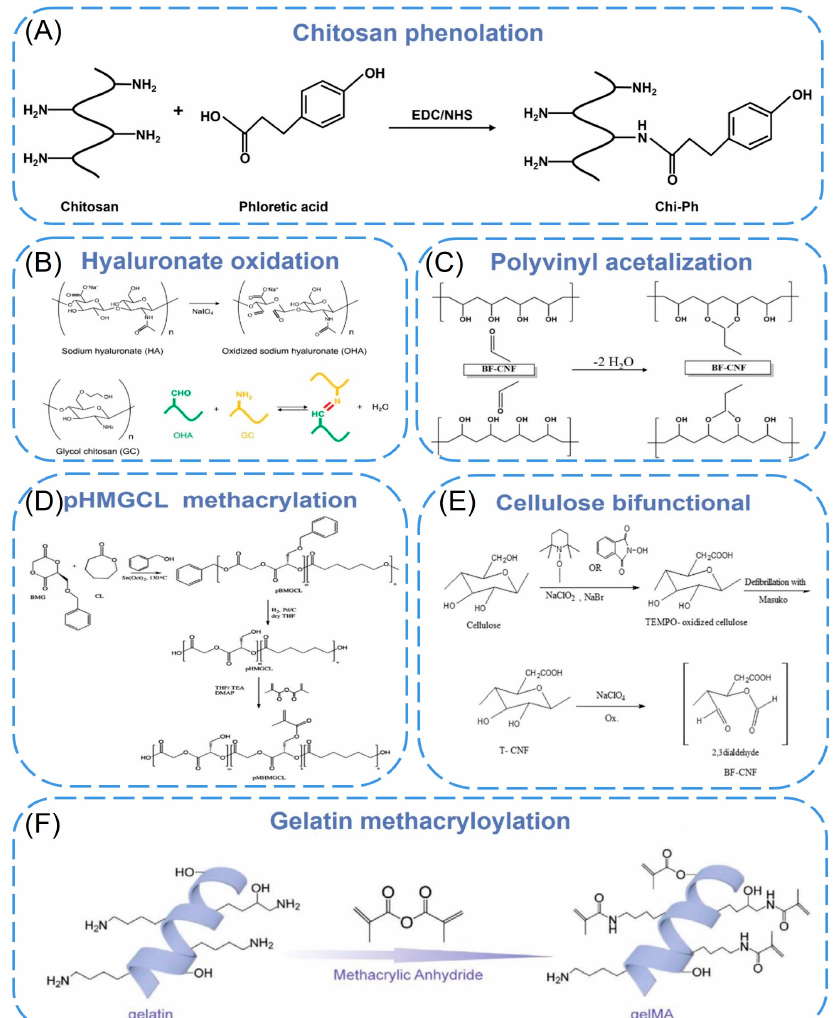
Figure 3. ( A ) Schematic illustration for conjugation of phloretic acid to chitosan using EDC/NHS